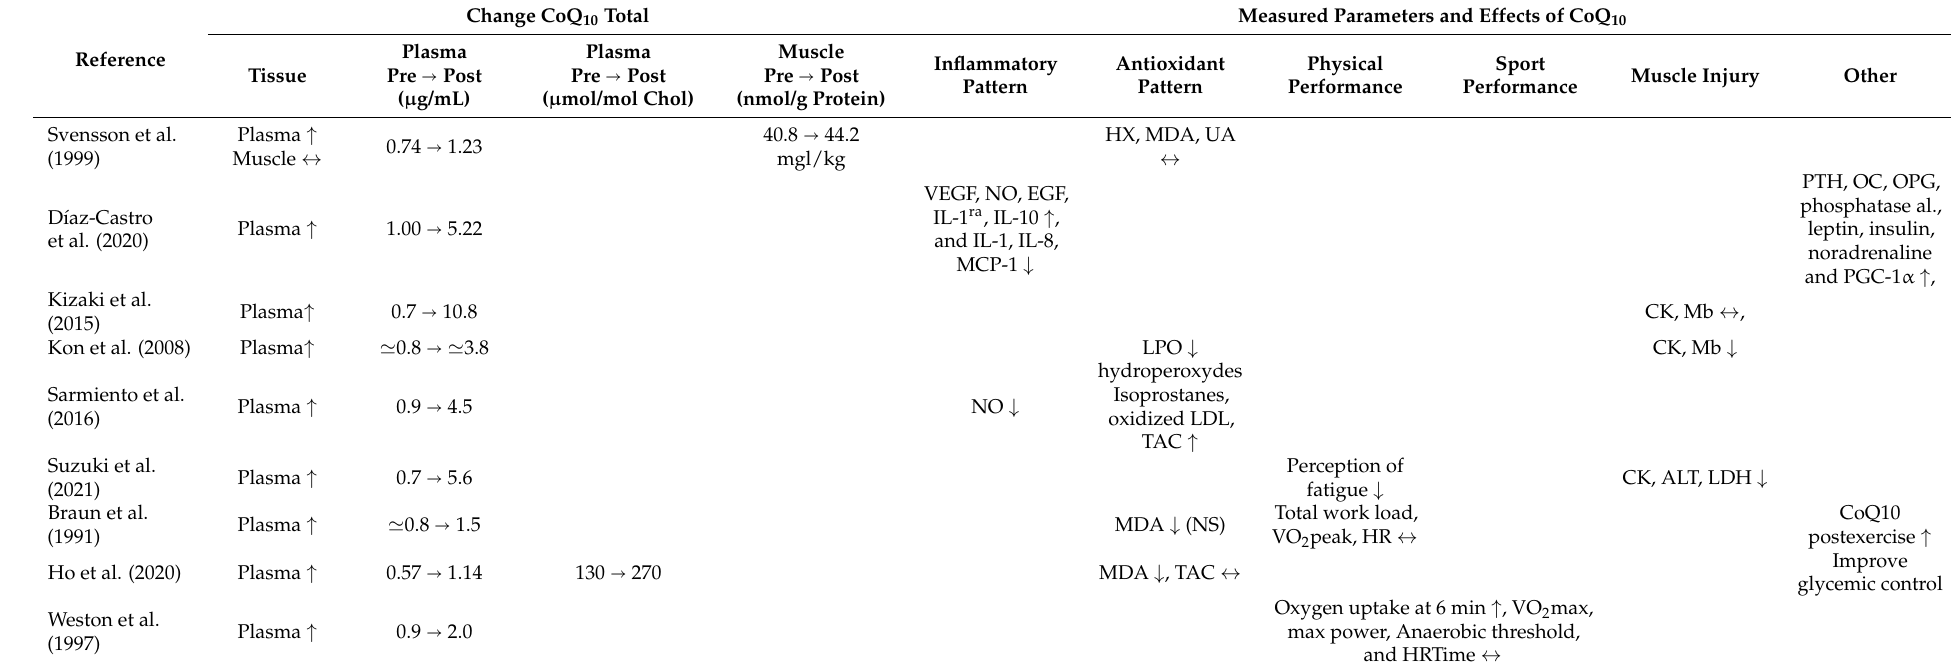
Table 3. Studies with the inclusion